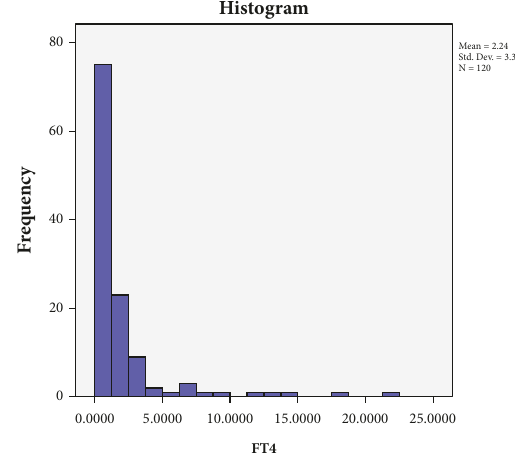
Figure 2: Distribution of FT4 level in study population